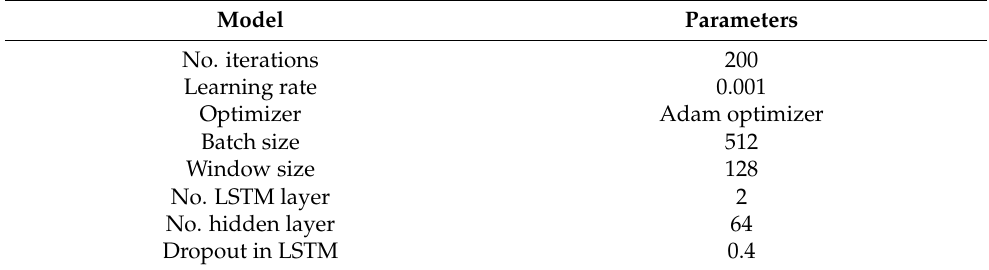
Table 3. Parameters in training and testing.